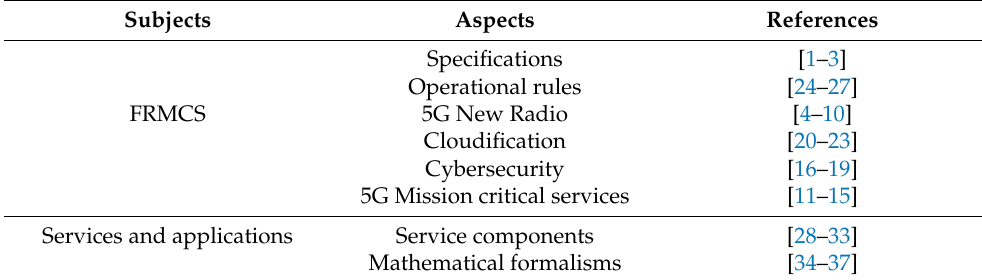
Table 1. Summary of related